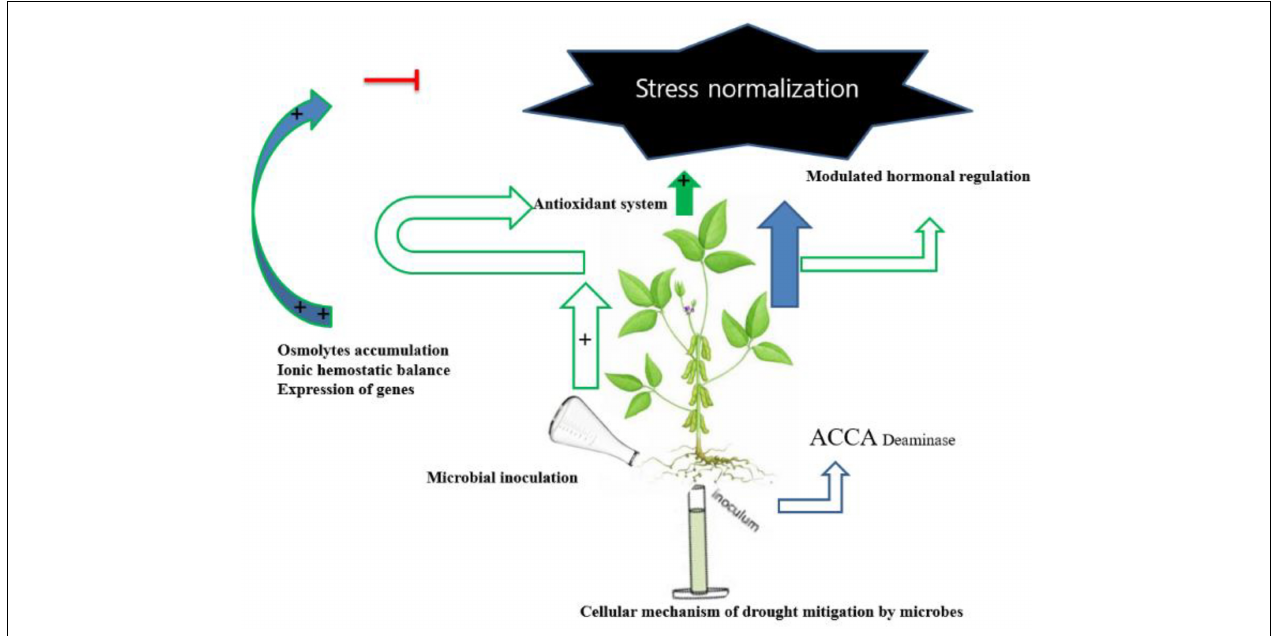
FIGURE 3 | Cellular mechanism of drought mitigation by microbes.